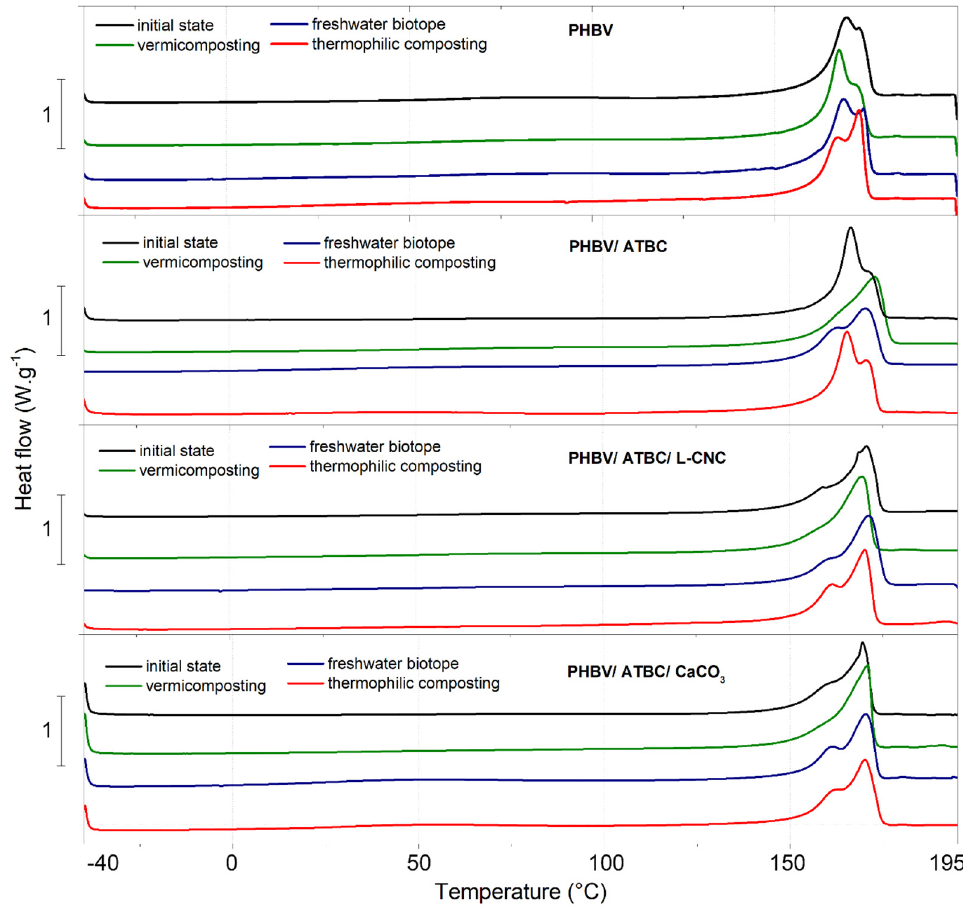
Figure 3. Thermal analysis (DSC) curves of PHBV bio-composites at initial state and after 30 days degradation.